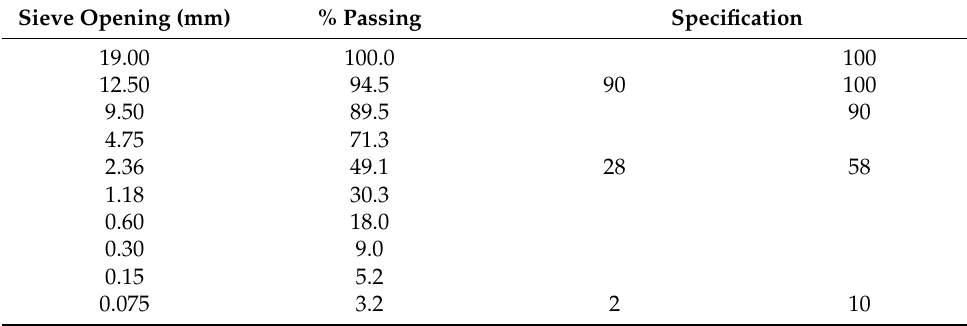
Figure 2. Aggregate gradation. Table 2. Aggregate gradation and MOT specification. Table 2. Aggregate gradation and MOT specification.